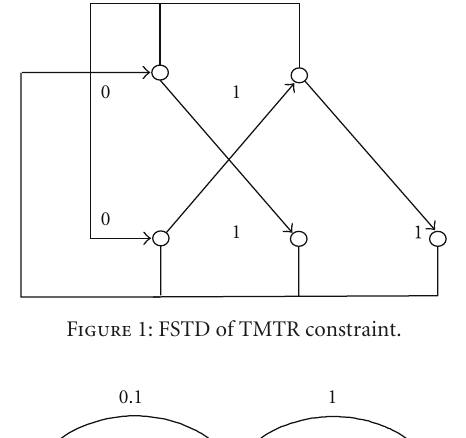
Figure 1: FSTD of TMTR constraint.